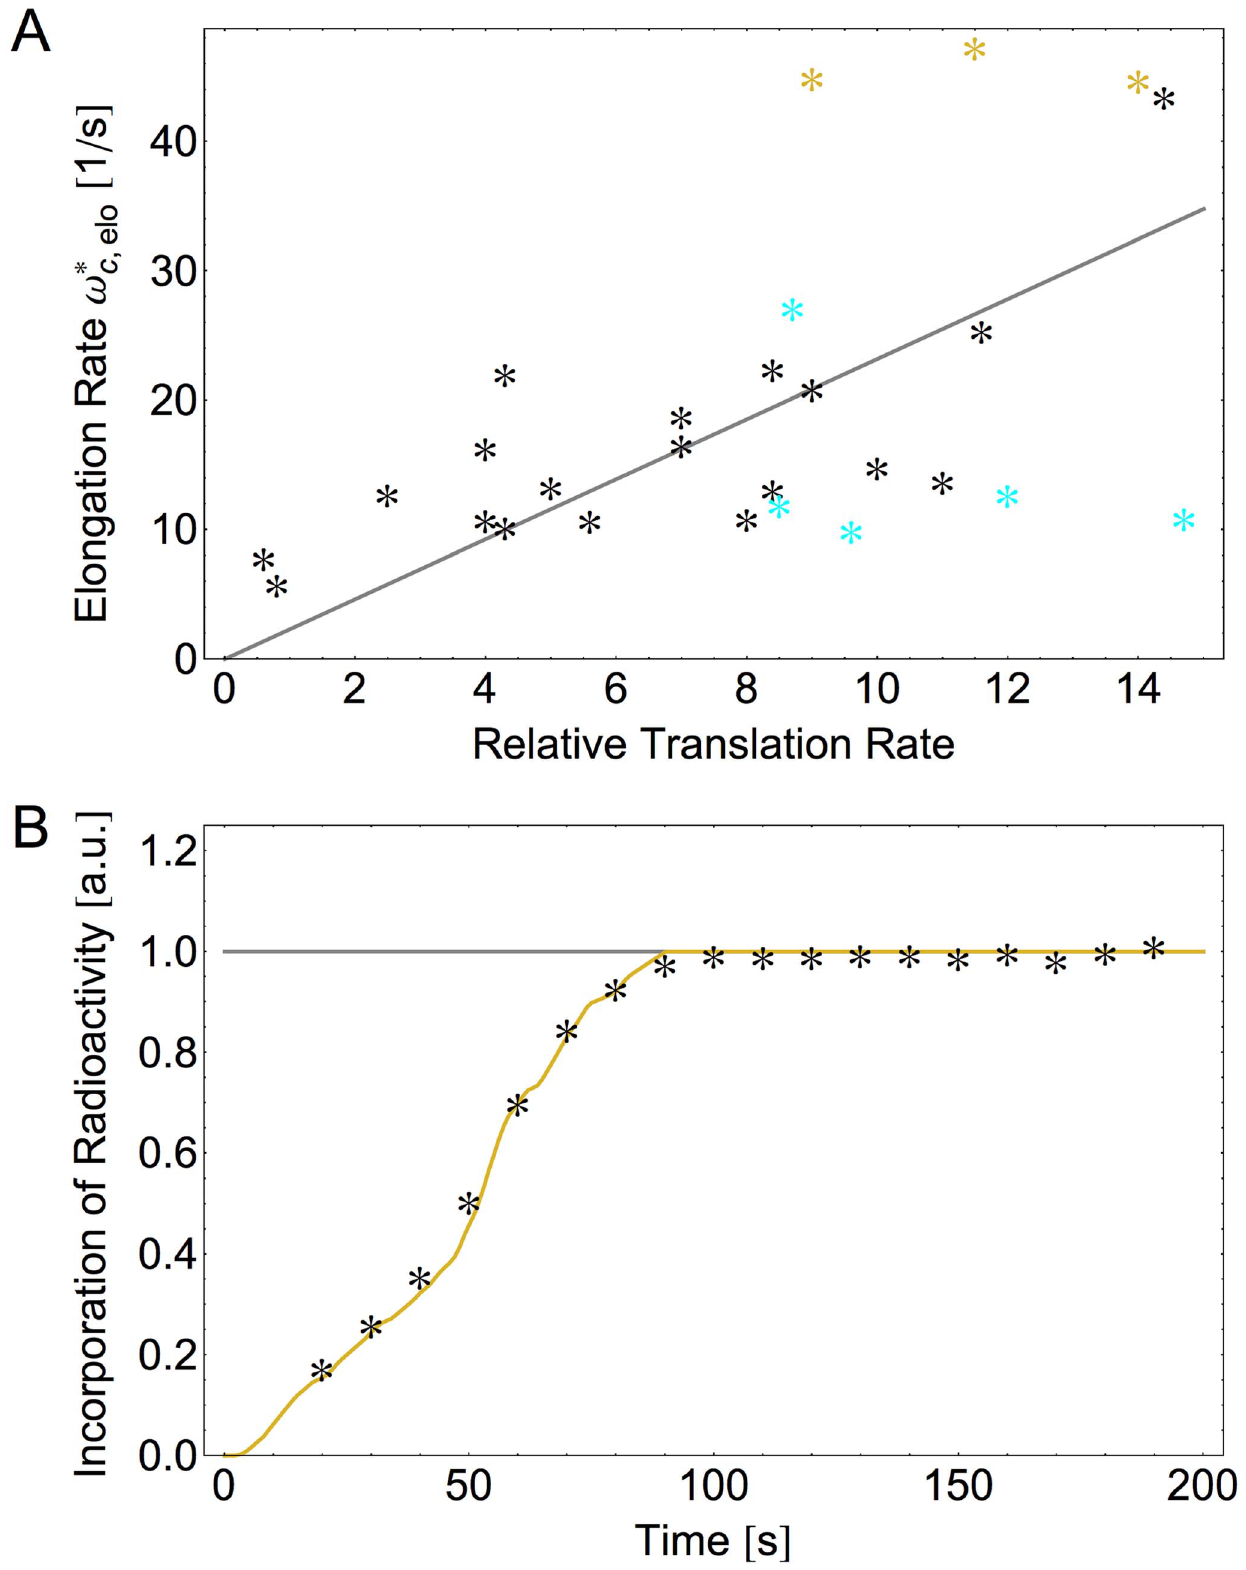
as determined here from c ,elo